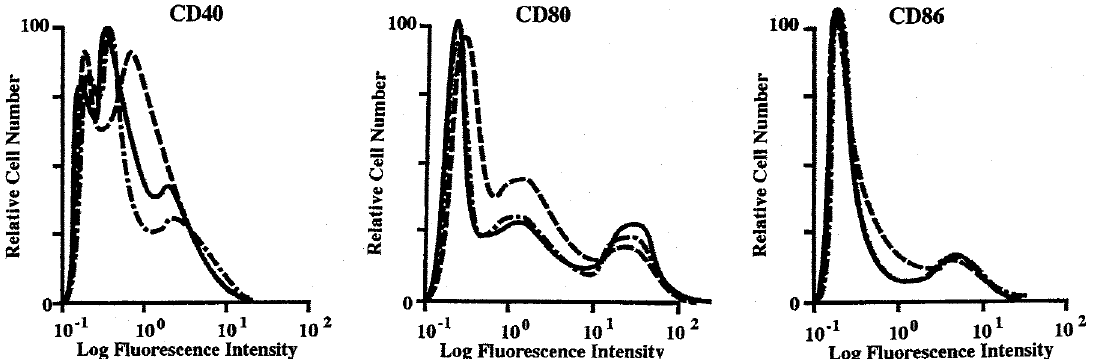
FIG. 4. Influence of disodium cromoglycate (DSCG) on co-stimulatory molecule expression on spleen cells induced by antigenic stimulation. Spleen cells (1 ´ 10 6 cells/ml) prepared from five individual mice 10 days after immunization were cultured with or without 2 ´ 10 –4 M of DSCG for 24h. The expression was analyzed by flow cytometer: (____) cultured without antigen; (_ _ _ _) cultured with antigen; (_ · _ · _) cultured with antigen and